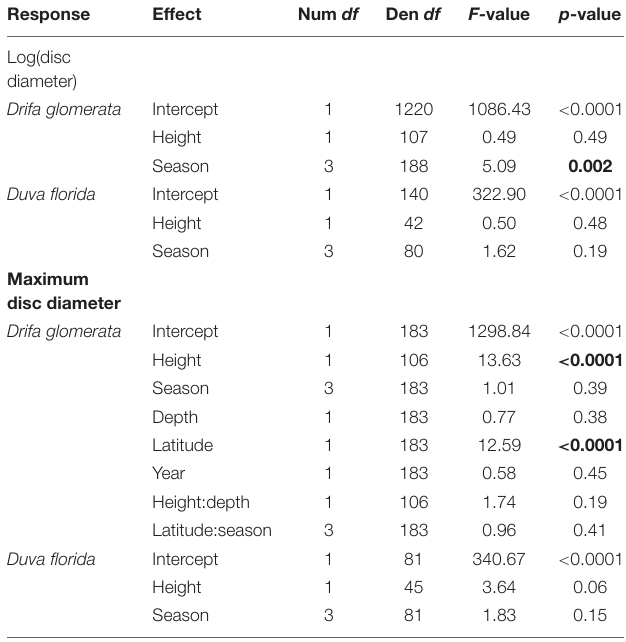
of a basket star collected in that trawl set. The closest set with a basket star reported was at ∼ 34 km from this site. Basket Star Abundance Most colonies had between 1 and 5 clinging basket stars, and only D. glomerata and D. florida had > 20 individuals on a single colony ( Figure 4D ). Drifa glomerata had both the highest ophiuroid occurrence (31.5%) and maximum number of ophiuroids per colony ( N = 111), followed by D. florida and P . racemosa (11 and 10.5%, N = 28 and 6, respectively), and Gersemia spp. (3.9%, N = 8). Number of basket stars per colony (in colonies with basket stars) significantly varied with colony height, but not with season for both D. glomerata and D. florida ( Table 4 ). There was also an effect of latitude for basket star abundance on D. glomerata ( Figure 6C ), but not of depth (variables not tested for D. florida ). The GAMM for both species indicated that, similarly, to the observed for presence-absence, the number of basket stars per colony increases with colony height up to ∼ 70 mm, when it levels off ( Figures 6D,E ).